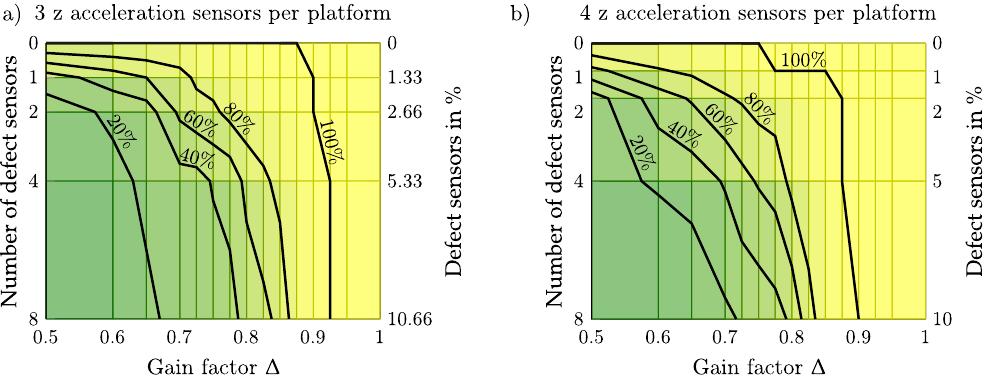
Figure 10. Improvement of fault detection using 4z acceleration sensors with sensor precision degradation. Figure 11 represents the influence of sensors with gain defects on the number of correctly detected rope faults in rope number 1.